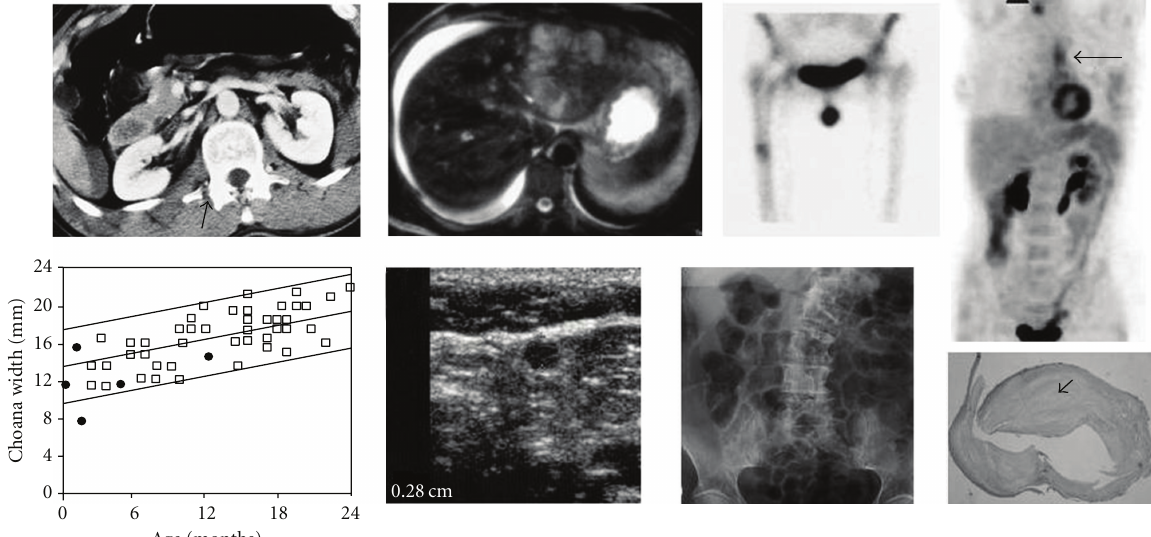
Figure 3: Sample images of 8 medical modalities. From left to right and top to bottom, the images are CT, MR, NM, PET, GX, US, XR, and PX, respectively.